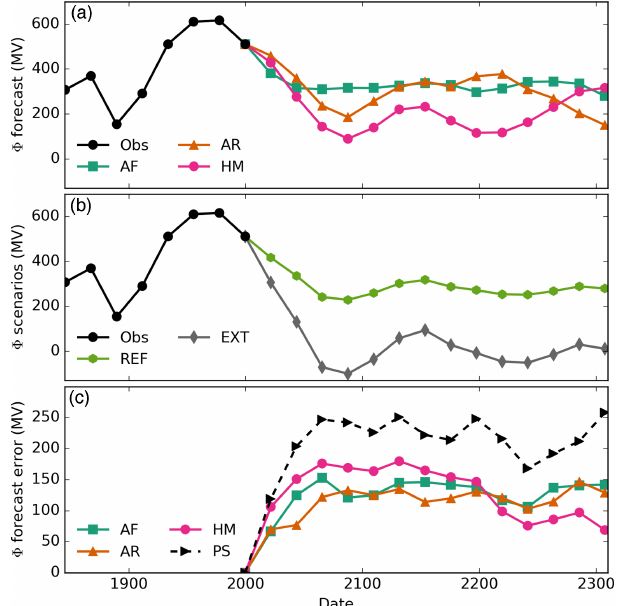
Figure 22. (a) Observations of (cid:56) (Obs) from 1850 until 1999, and the three scenarios from 1999 until 2300, from the analogue fore- cast (AF), auto-regressive model (AR), and harmonic analysis (HM) methods. (b) The CMIP6 reference scenario (REF) and extreme scenario (EXT). (c) The error for the AF, AR, HM, and PS methods, estimated by employing a bootstrap hindcast approach, calculating the root-mean-square of the hindcast errors for 23 prior grand so- lar maxima in the φ record. The occurrence of unphysical negative values comes from the original modulation potential data, and not necessarily from the methods; see Fig.